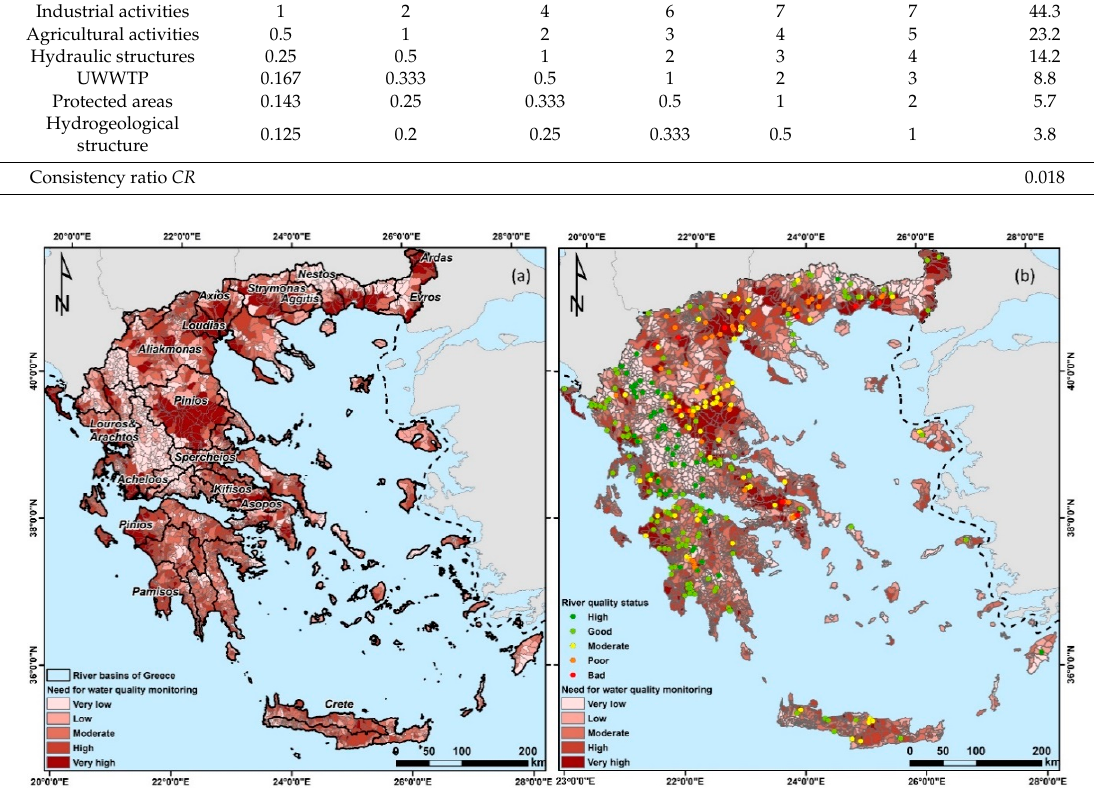
Figure 4. ( a ) Basins of Greece with increased need for water quality monitoring and ( b ) results of the national monitoring program of the water status in Greece (quality status 2012–2015).